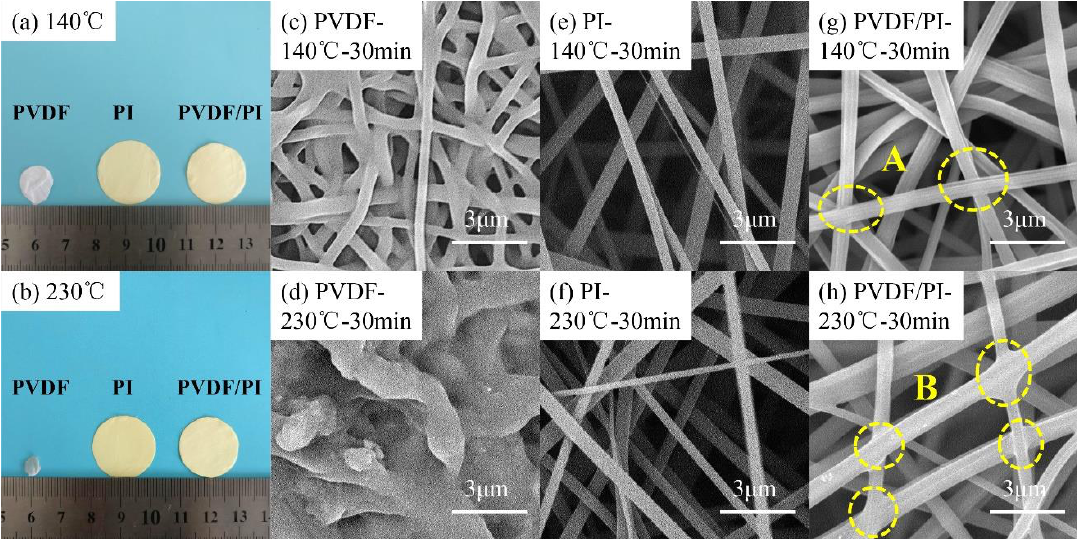
Figure 4. Photograph ( a , b ) and SEM images of PVDF ( c , d ), PI ( e , f ), and PVDF/PI ( g , h ) electrospun membranes before and after heat treatment.